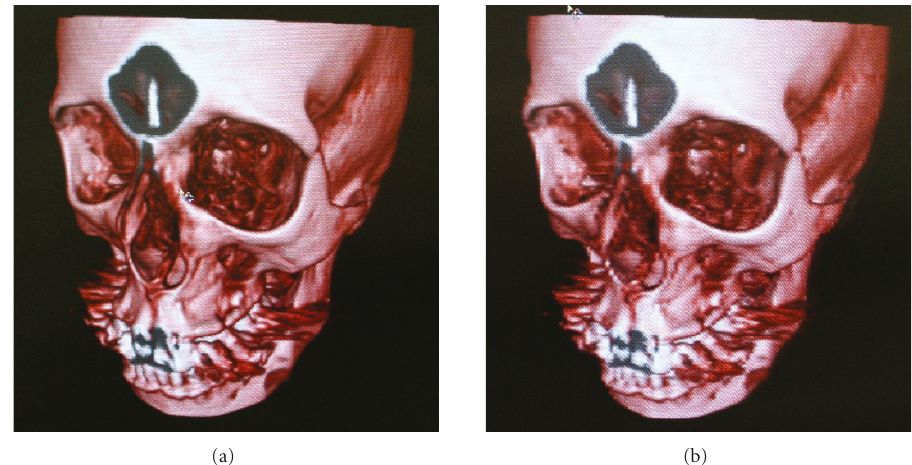
Figure 10: (a) The lenticular screen has been photographed to show how a view is being displayed, rendered at the 1/3 orthogonal grid resolution. (b) The same view, but sampled at 0 . 375 the resolution of the view in (a). Though the downsampling is visible, the e ff ect is less strong than might be expected. This can be contributed to the fact that the displaying process possesses a low-pass filter character, due to e ff ects like crosstalk.